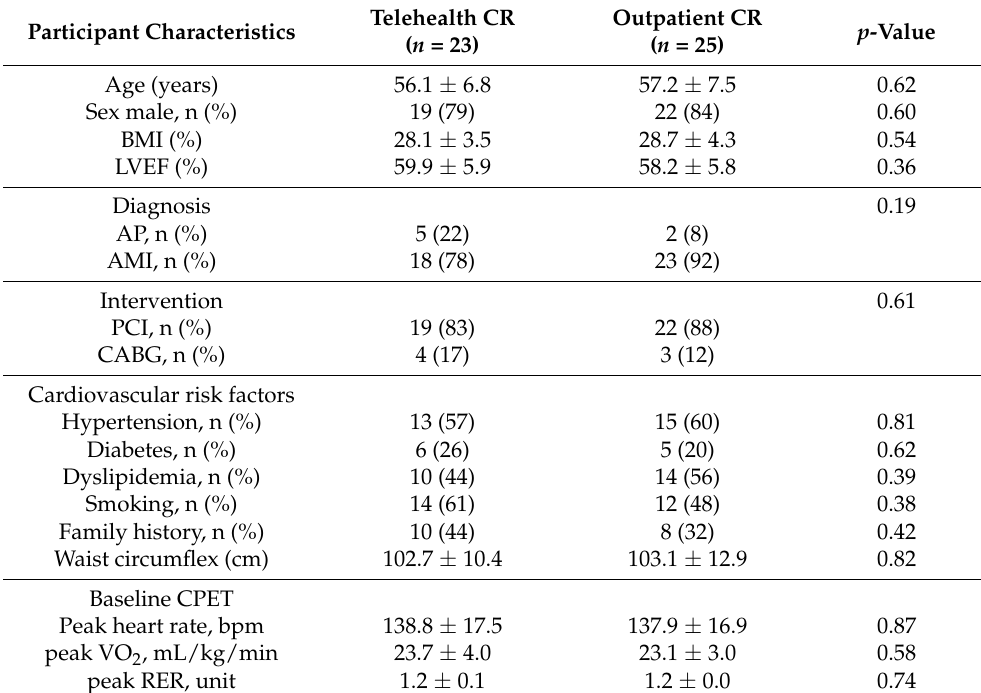
Table 1. Baseline demographic and clinical characteristics of the participants.